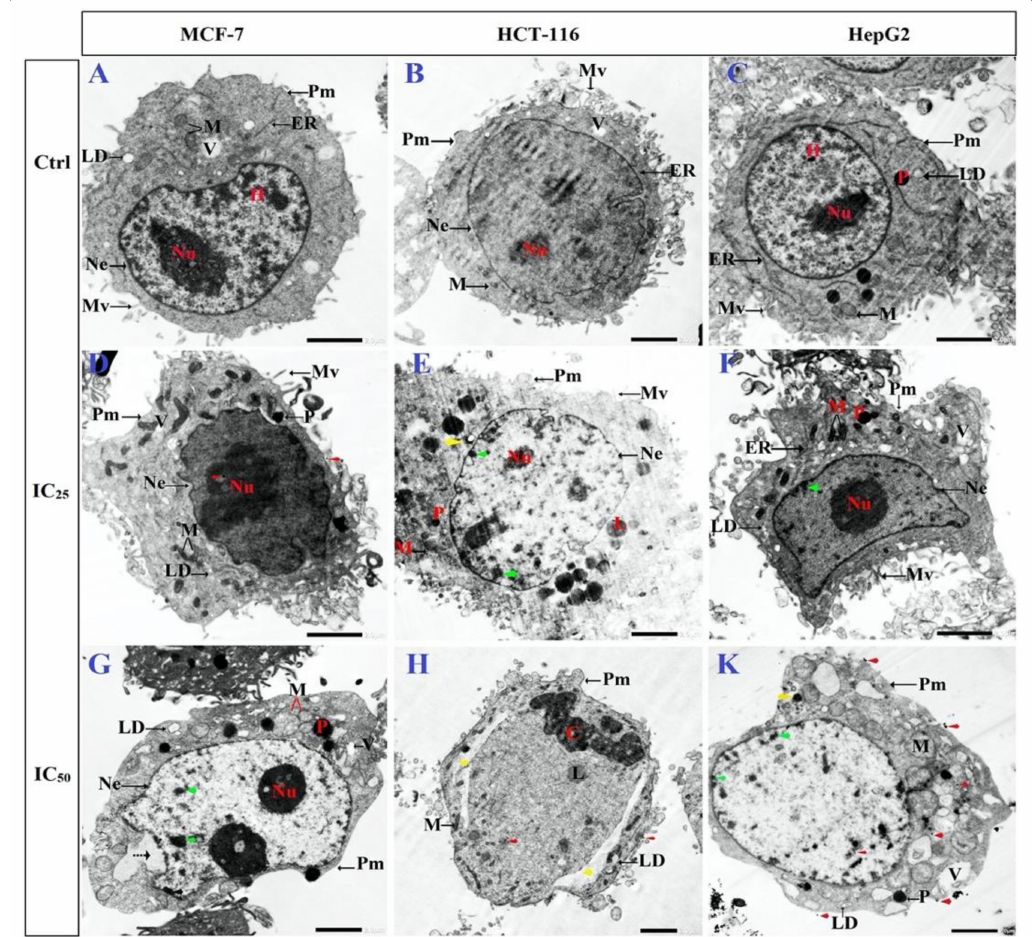
Figure 4. Transmission Electron Microscopy (TEM) micrographs of MCF-7, HCT-116, and HepG2 illustrating ultrastructural features before treatment ( A – C ), after exposure to N-SNPs at IC25 (27, 28, and 40 µ g / mL, respectively) ( D – F ), and after exposure to N-SNPs at IC50 (54, 56, and 80 µ g / mL, respectively) ( G – K ). Images show irregular plasma membrane (Pm), low distribution or absence of microvilli (Mv), and endoplasmic reticulum (ER), high incidence of lipid droplets (LD), mitochondria (M), lysosomes (L), vacuoles (V), large vacuoles (headed yellow arrow), autophagic vacuoles (yellow arrow), cytoplasmic dissolution (cut arrow), irregular nuclear envelope (Ne), marginated and aggregated heterochromatin (green arrow), and condensed chromatin (C). Red arrows show the distribution of N-SNPs in cytoplasm, plasma membrane, and organelles. Scale bar = 2 µ